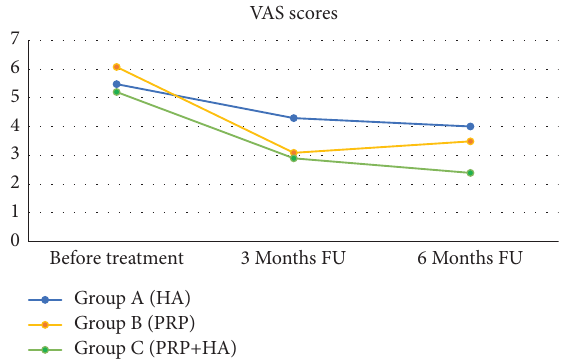
Figure 1: Te evolution of the mean visual analogue scale (VAS) scores in the three groups. HA: hyaluronic acid, PRP: platelet-rich plasma, and FU: follow-up.